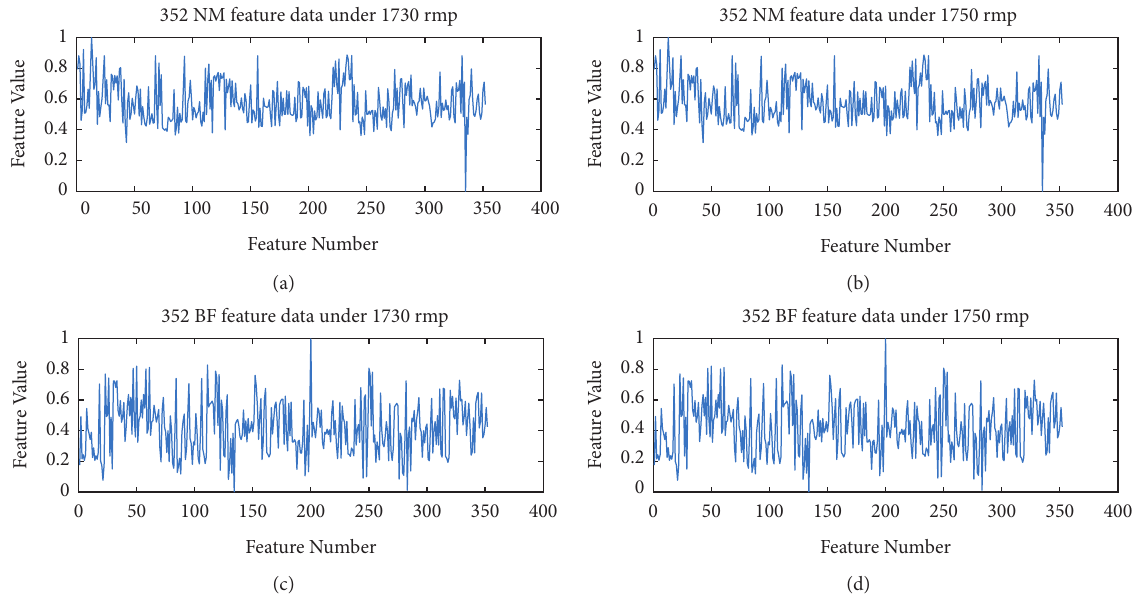
Figure 10: 352 statistical features extracted from NM and BF vibration signals under 1730rmp and 1750rmp (the feature data are normalized). (a) NM feature data under 1730rmp. (b) NM feature data under 1750rmp. (c) BF feature data under 1730rmp. (d) BF feature data under 1730rmp.